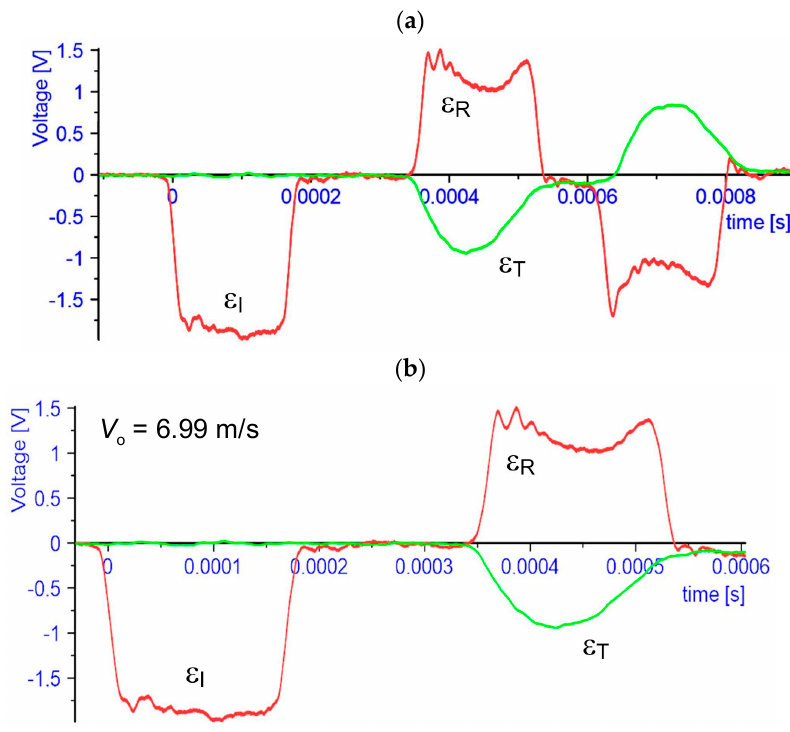
Figure 3. Results from SHPB (sample 6_3). ( a ) before cut ( b ) after cut